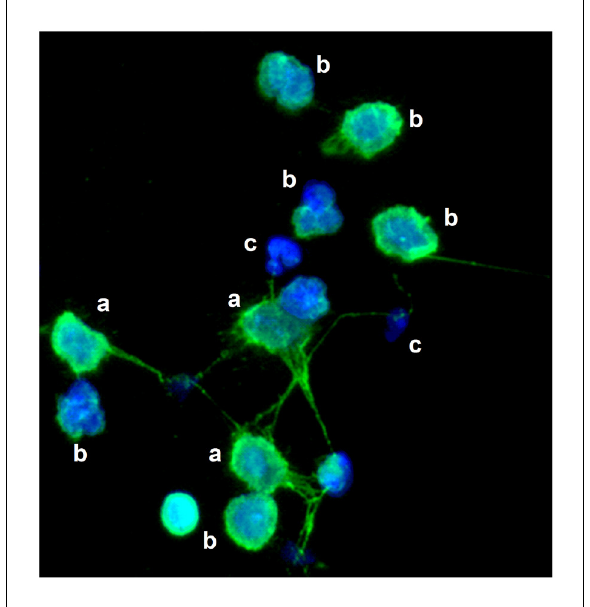
Figure 1: Fluorescence micrograph showing isolated human neutrophils undergoing NETosis. Following activation with phorbol myristate acetate (6.25 ng/mL), a potent stimulator of nicotinamide adenine dinucleotide phosphate (NADPH) oxidase, and the production of reactive oxygen species, adherent neutrophils were exposed, sequentially, to unlabelled polyclonal rabbit antibodies, to citrullinated histone H3 residues and to Alexa Fluor 488 labelled goat anti-rabbit antibodies, before DNA was stained with a nuclear dye (DAPI). DNA is stained blue, while neutrophil extracellular traps (NETs), containing both DNA and citrullinated histone residues, are stained green. Neutrophils which have undergone NETosis, cells in the early stages of NETosis, and a non-NETotic neutrophil showing intact, multi-lobed nuclear morphology (stained blue), are labelled a, b and c,